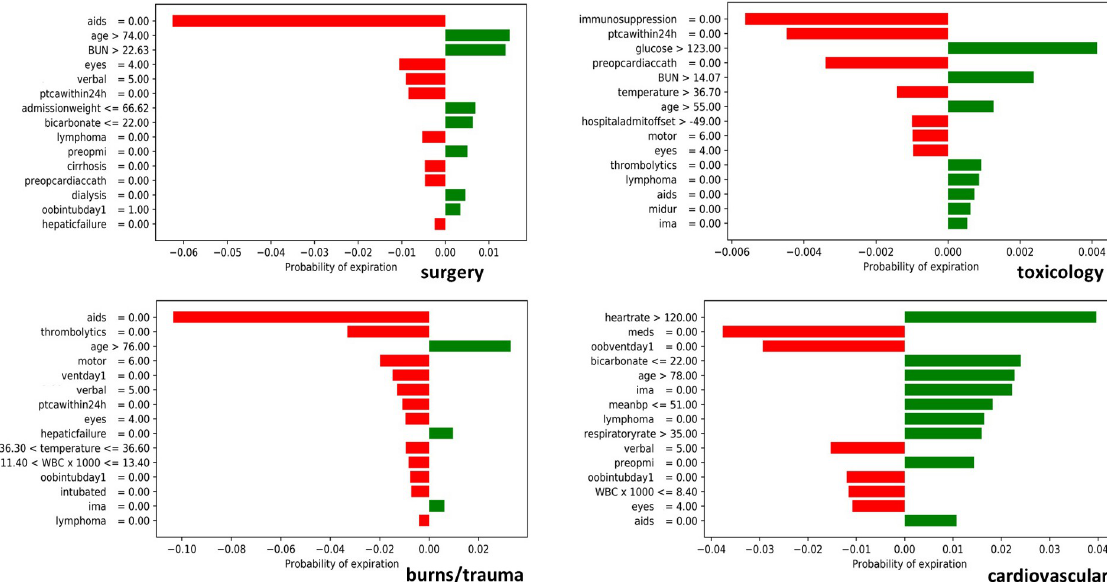
Fig 5. Feature importance of individual patients calculated using LIME in surgery, toxicology, burns-trauma, and cardiovascular disease groups.